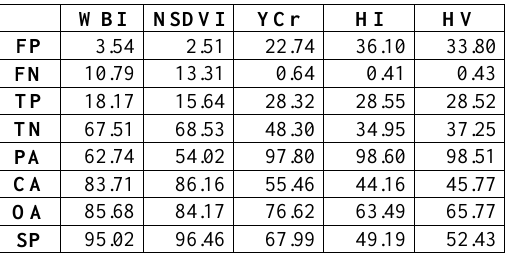
Table 1: Comparison of shadow detection methods